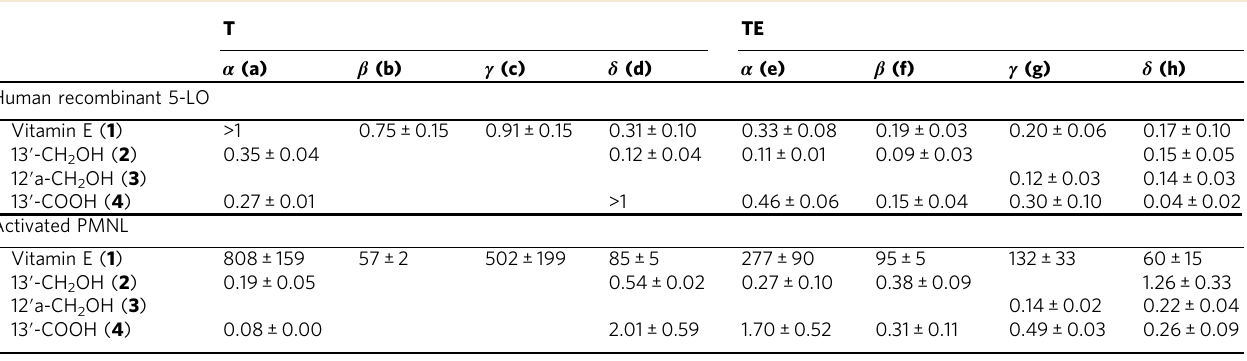
Table 1 Inhibitory activity of vitamin E derivatives against 5-LO in cell-free and cell-based test